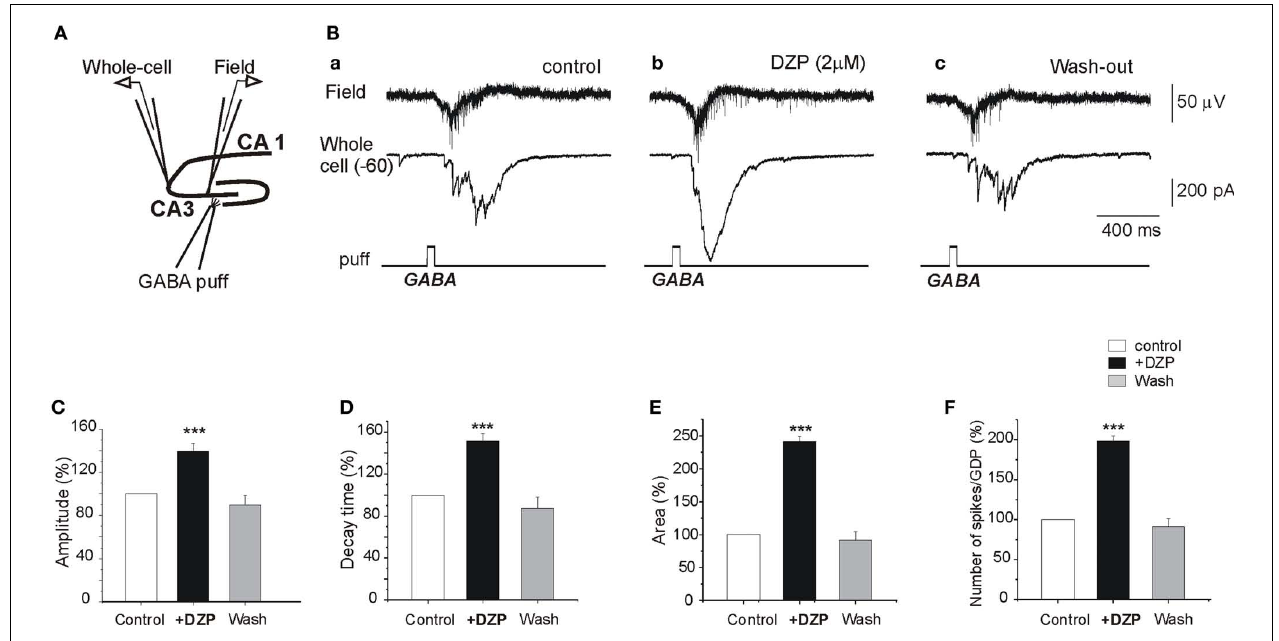
returned to control values after wash out of DZP (Bc) . (C–E) Quantification of the effects of DZP on whole cell recorded postsynaptic currents: the amplitudes of the currents, the decay time and the area of whole cell recorded responses were significantly augmented by DZP. (F) Quantification histogram of mean number of spikes associated with puff GABA generated GDPs (a time window of 1s from the GDP onset from GABA puff was